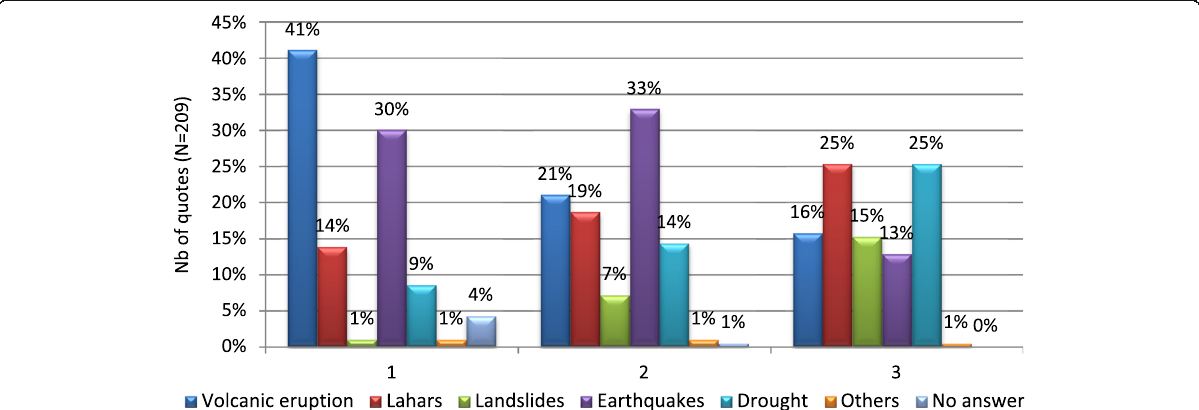
Fig. 3 Ranking of the first 3 answers to the question: “ Can you rank these natural hazards from the more important to the less important for you?